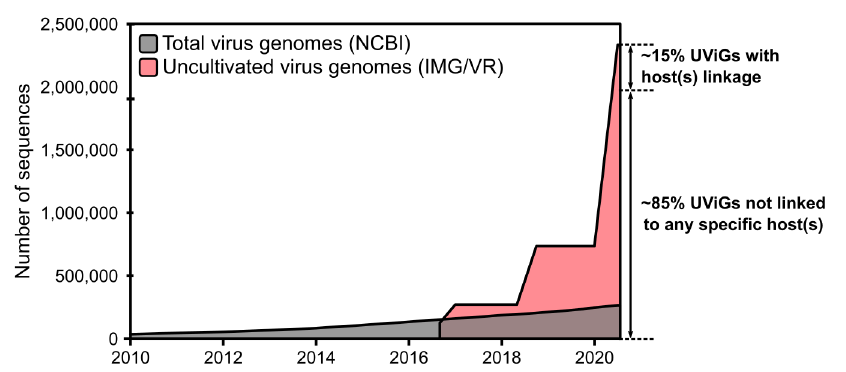
Figure 3. Growth of virus genome databases from 2003 to 2020. The total number of genomes from isolates was based on queries to the NCBI nucleotide database portal, while the number of uncultivated virus genomes (UViGs) was estimated by compiling data from the literature and from the IMG/VR database, as in Paez-Espino et al.